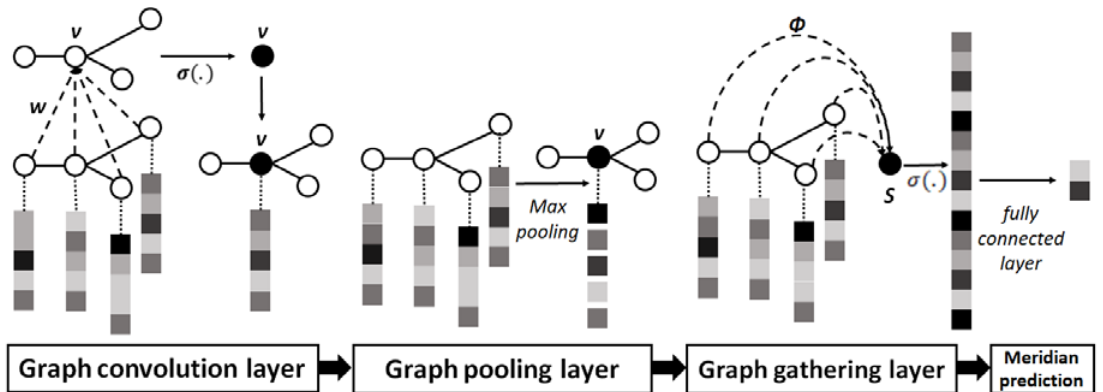
Figure 2. The simple illustration of the graph convolutional neural network (GCN) model.